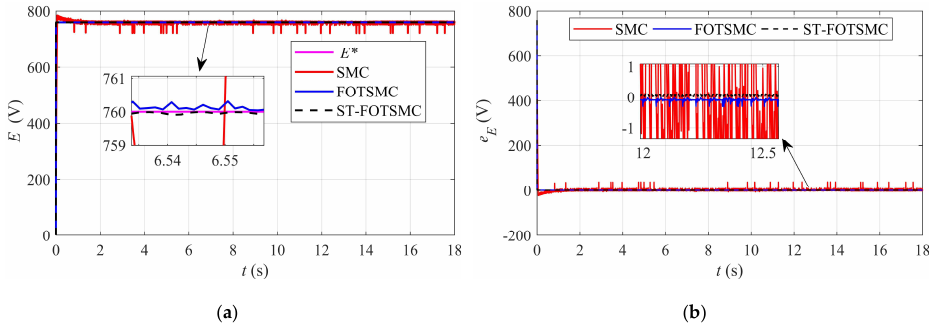
Figure 9. ( a ) DC-link voltage; ( b ) DC-link voltage error comparison under normal conditions.